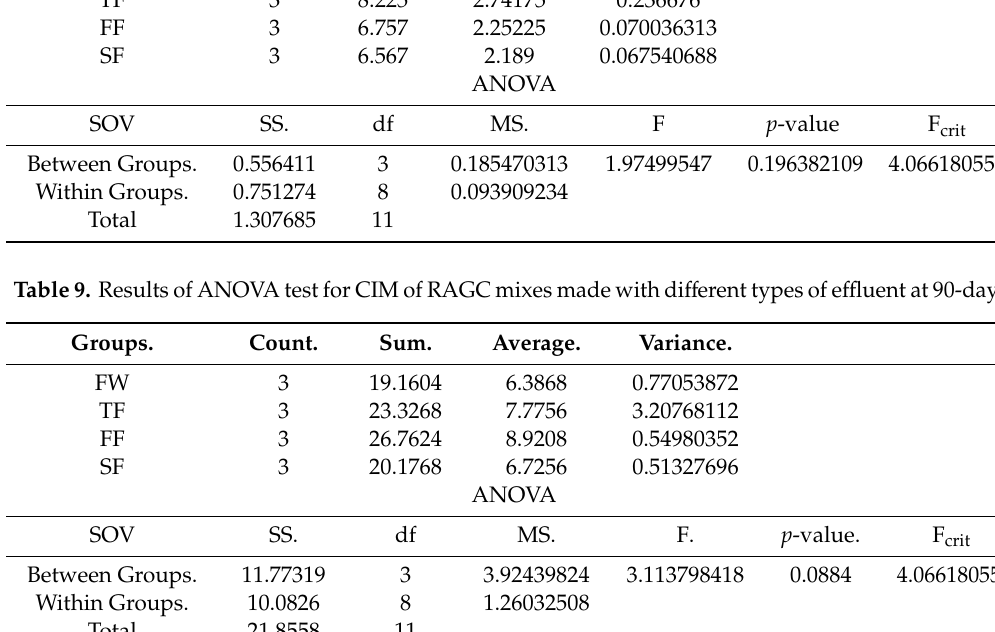
Table 10. Results of the ANOVA test for the sulfuric acid attack of RAGC mixes made with di ff . types of e ffl uent at 90-days. Groups. Count. Sum. Average. Variance. FW 3 37.565325 12.521775 0.4132 TF 3 44.741025 14.913675 0.4594 FF 3 SF 3 ANOVA SOV SS. df MS. F. p -value. F crit Between Groups. 3 Within